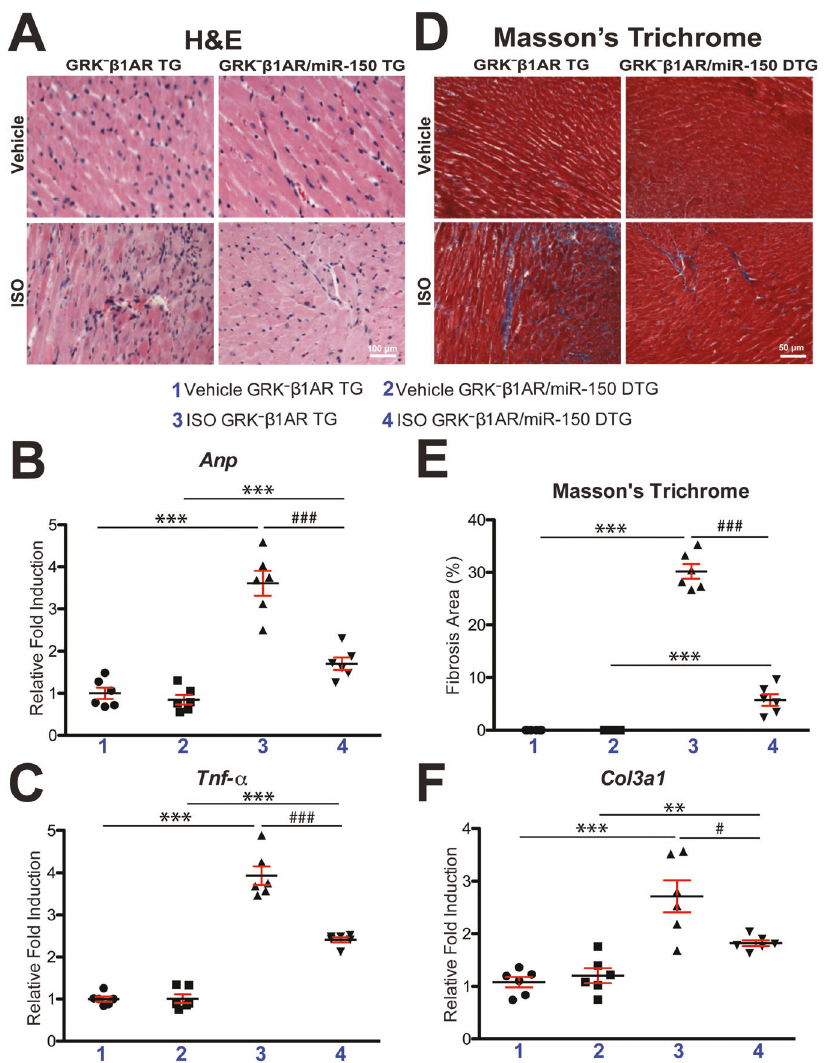
Fig. 2 Cardiomyocyte-speci fi c overexpression of GRK − β 1 AR induces cardiac stress and fi brosis after chronic isoproterenol treatment, which is alleviated by miR-150. A Representative hematoxylin and eosin (H&E) images from heart sections at 1-week post-treatment show a decrease in abnormal architecture and cellular integrity, and in disorganized structure in ISO GRK − β 1 AR;miR-150 DTG hearts compared to ISO GRK − β 1 AR TG controls- Scale bar: 100 μ m. B , C Real-Time Quantitative Reverse Transcription (QRT)-PCR analyses of Anp ( B ) and Tnf- α ( C ) expression for cardiac damage and in fl ammation in GRK − β 1 AR;miR-150 DTG hearts compared to GRK − β 1 AR TG controls at 1-week post- treatment. N = 6 per group. Data are presented as fold induction of gene expression normalized to glyceraldehyde-3-phosphate dehydrogenase ( Gapdh ). Two-way ANOVA with Tukey multiple comparison test. *** P < 0.001 vs. vehicle; ### P < 0.001 vs. ISO GRK − β 1 AR TG. D , E Representative Masson ’ s trichrome images in heart sections from 4 experimental groups at 1-week post-treatment ( D ) and fi brosis quanti fi cation in whole left ventricles (LVs) ( E ). Scale bar: 50 μ m. N = 6 per group. Two-way ANOVA with Tukey multiple comparison test. *** P < 0.001 vs. vehicle; ### P < 0.001 vs. ISO GRK − β 1 AR TG. F QRT-PCR analysis of fi brotic Col3a1 expression in GRK − β 1 AR;miR-150 DTG hearts compared to GRK − β 1 AR TG controls at 1-week post-treatment. N = 6 per group. Data are presented as fold induction of gene expression normalized to Gapdh . Two-way ANOVA with Tukey multiple comparison test. ** P < 0.01 or *** P < 0.001 vs. vehicle; # P < 0.05 vs. ISO GRK − β 1